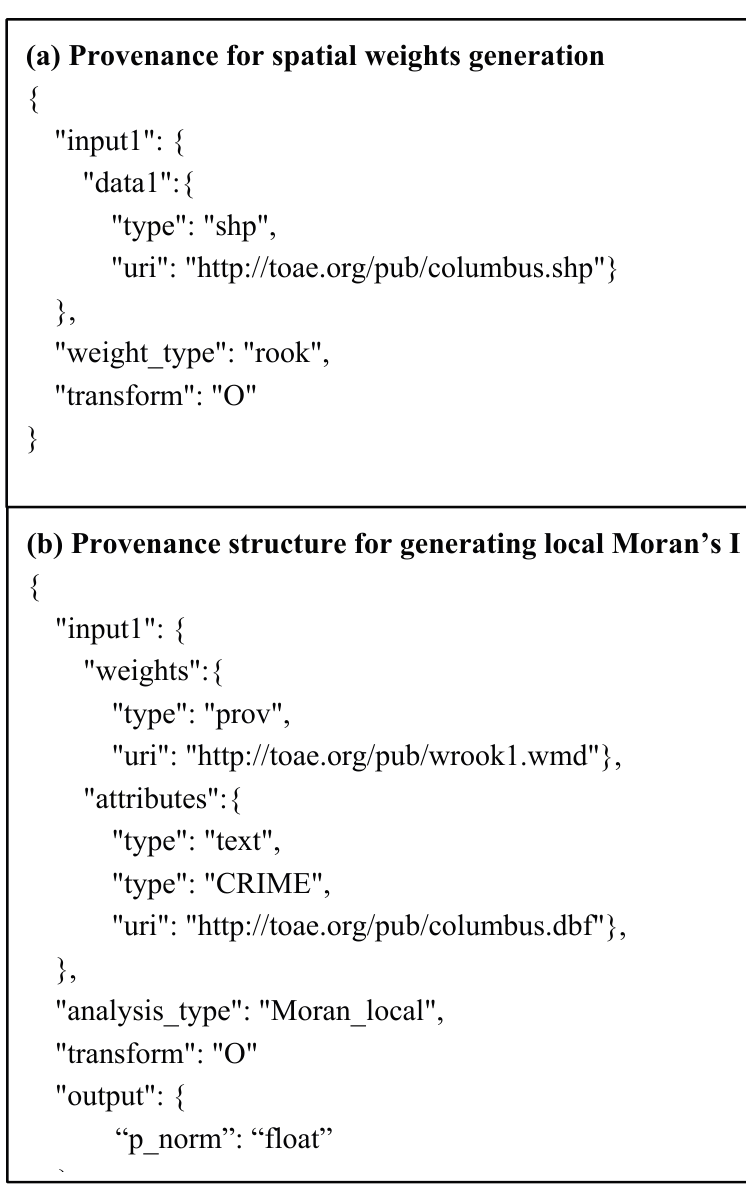
Figure 6. Provenance meta-data for spatial analytical workflows in JavaScript Object Notation (JSON)